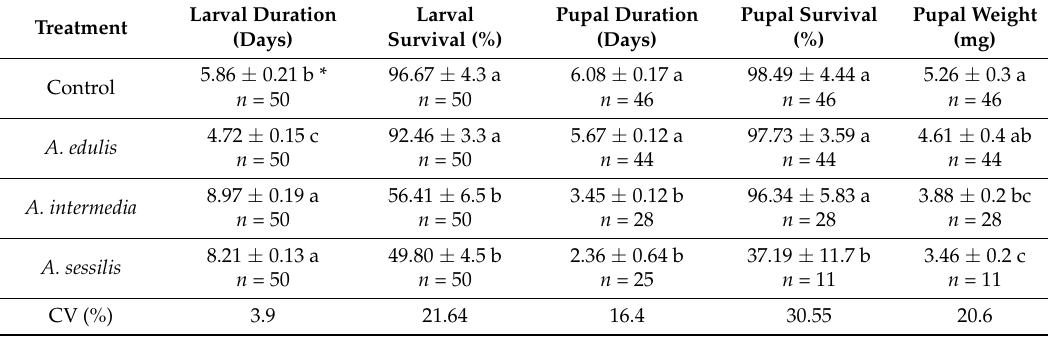
Table 1. Duration (days) and survival (%) of larval and pupal stages and pupal weight (mg) of Plutella xylostella L. treated with Alibertia edulis , Alibertia intermedia , and Alibertia sessilis aqueous extracts. Larval Duration Larval Treatment (Days) Survival (%)